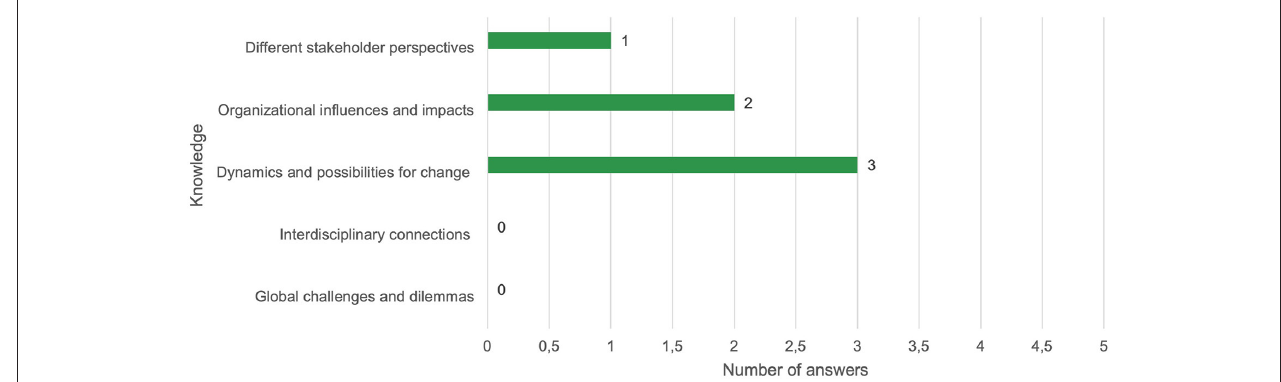
FIGURE 6 | Sustainability knowledge.